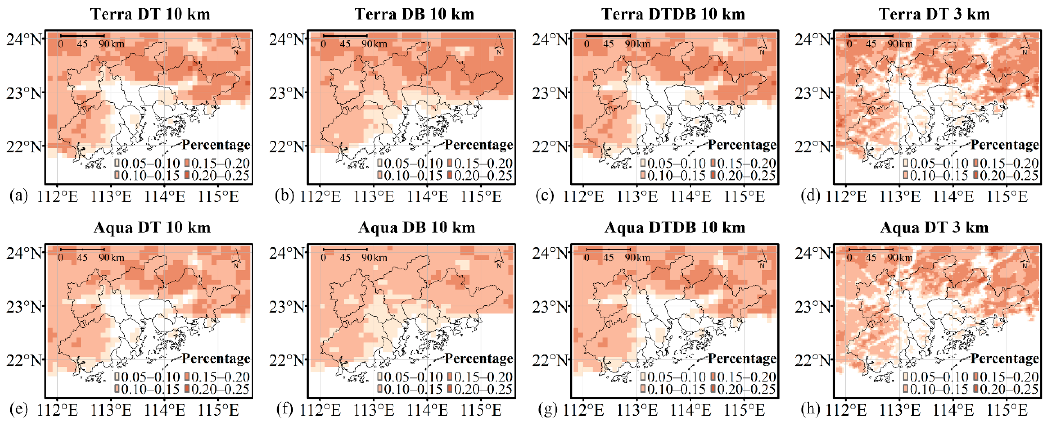
Figure 6. Ten-year (2006–2015) mean sampling frequencies for Terra ( a – d ) and Aqua ( e – h ) MODIS aerosol products.